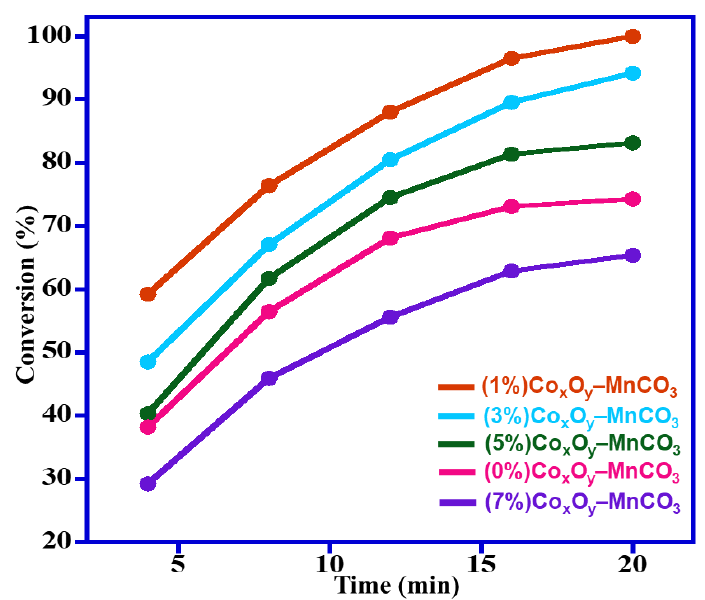
Figure 6. Graphical illustration of BzOH oxidation over (0%)Co x O y –MnCO 3 , (1%)Co x O y –MnCO 3 ,